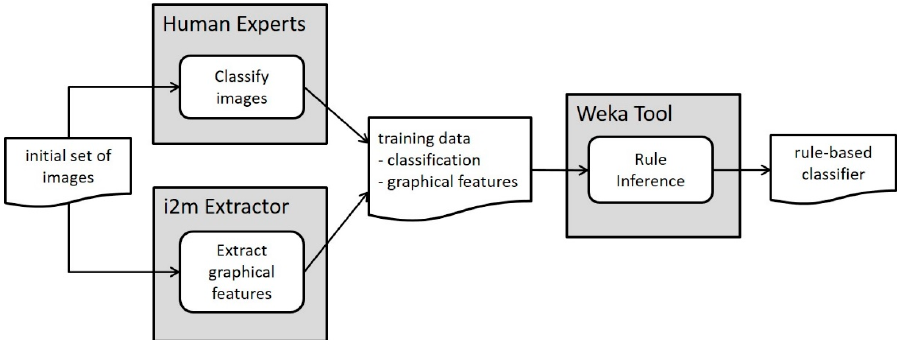
Figure 12. Inference stage: emulating the expert’s classification through machine learning.